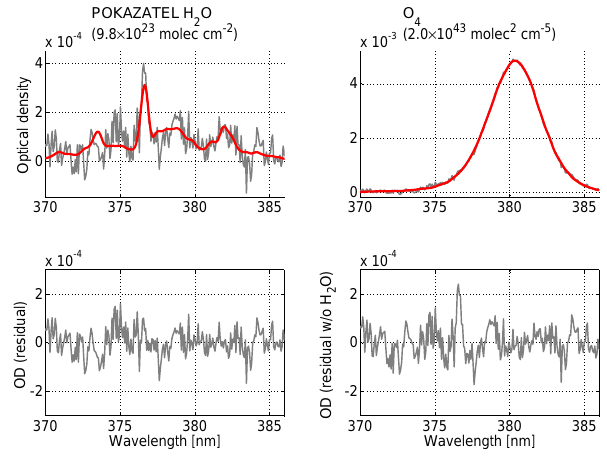
Figure 9. Fit result for the same MAX-DOAS spectrum as that used in Fig. 7 to show the water vapour absorption at 376nm, which cor- relates for the M91 data set with R 2 = 0 . 6 and a slope of 1.2 ± 0.3, with the water vapour absorption at 363nm. The measurement error of this individual fit amounts to